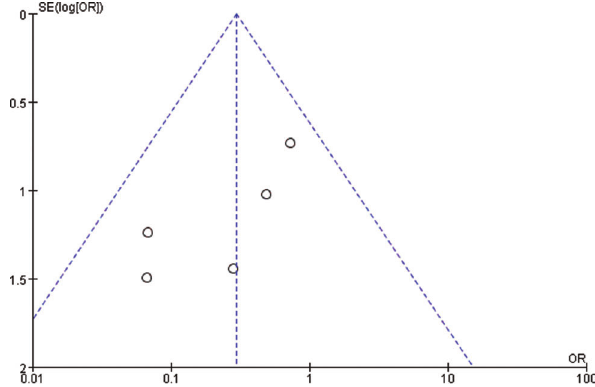
Figure 5 - Funnel plot for the detection of publication bias (comparison of arthroplasty